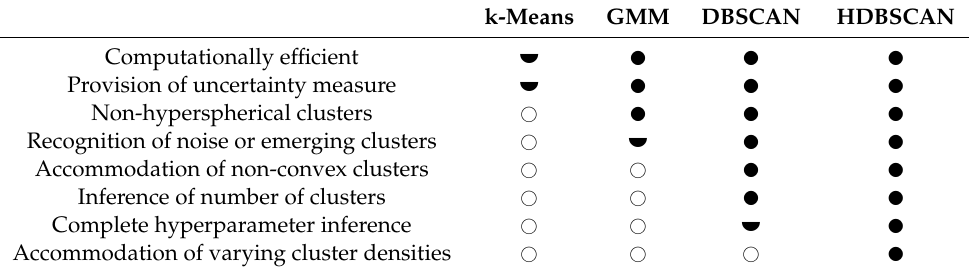
Table 1. Qualitative capability comparison of selected clustering algorithms.